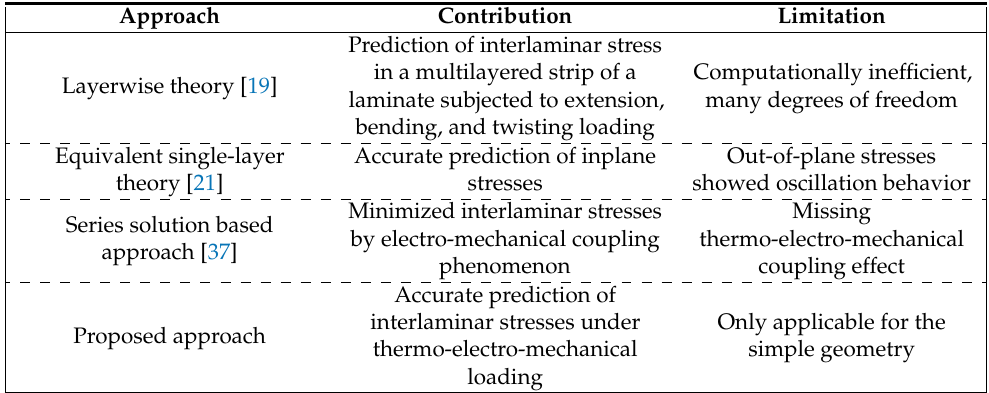
Table 2. Comparative analysis of the proposed approach with the previous literature approaches.